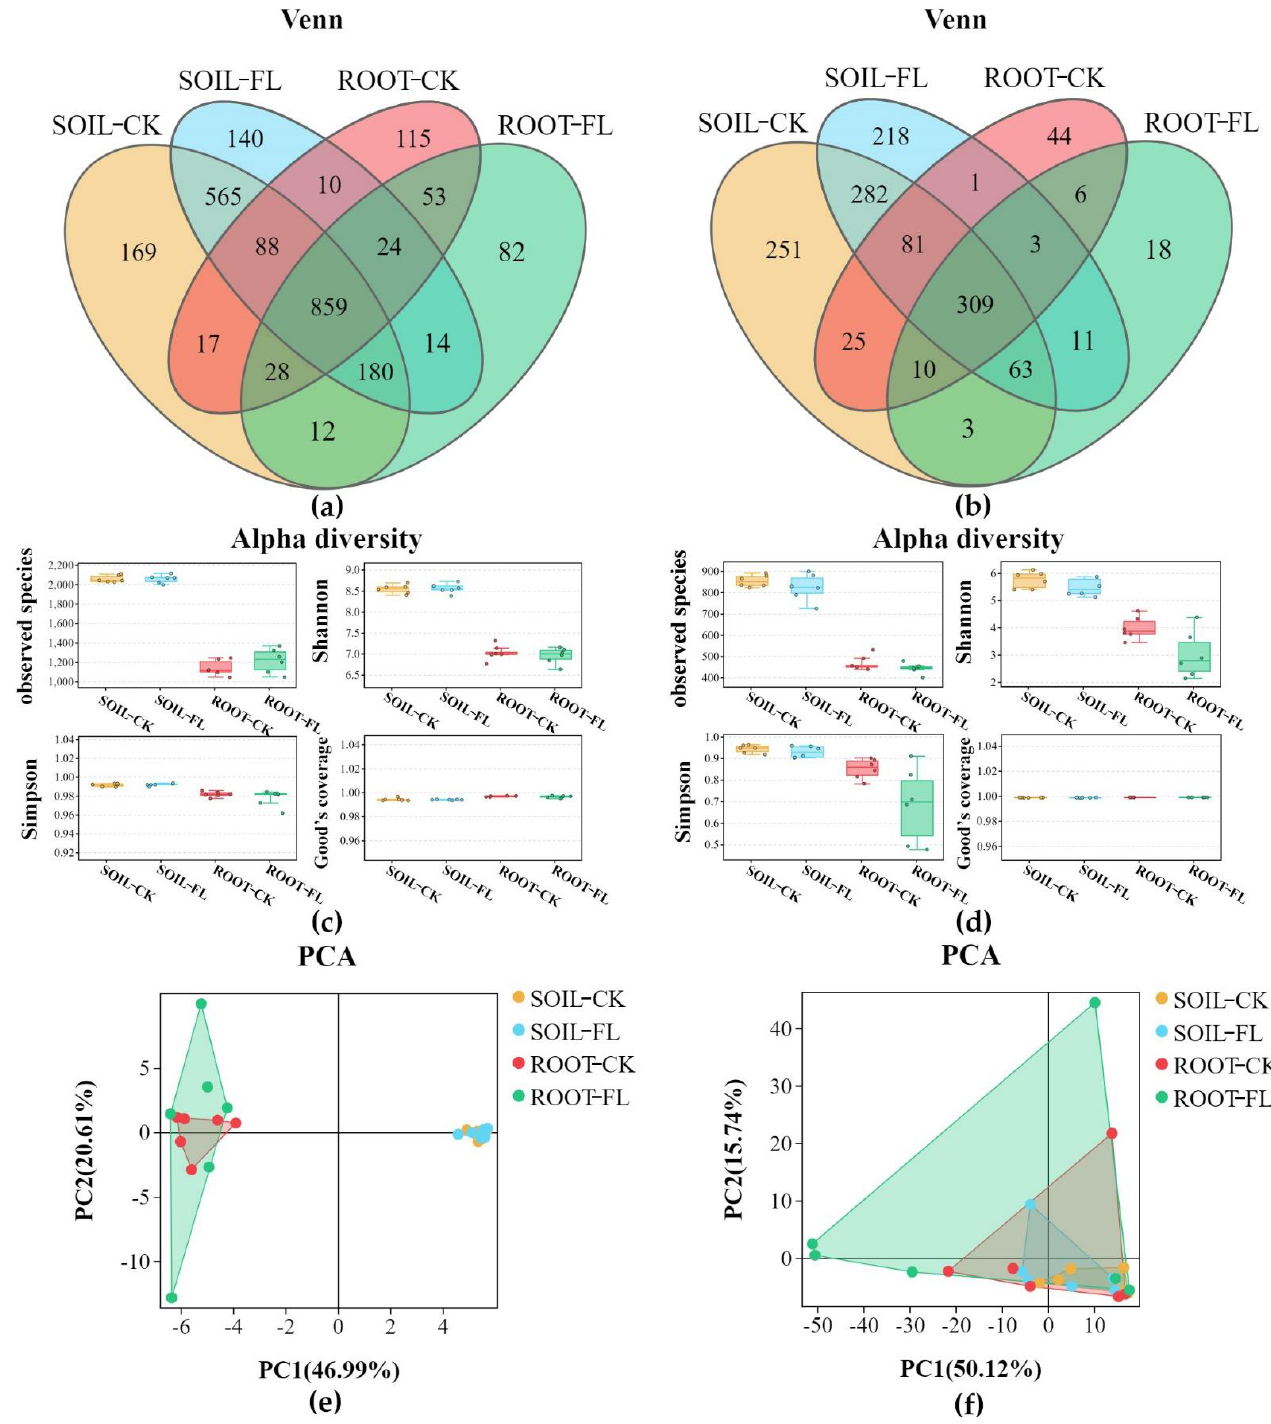
Figure 3. Venn analysis, alpha diversity analysis, and principal component analysis based on the recovered OTUs. ( a , b ) Venn analysis of bacteria and fungi, respectively; ( c , d ) alpha diversity analysis for bacteria and fungi using Tukey’s HSD; ( e , f ) principal component analysis of the OUT of the bacteria and fungi from soil and roots under FL and CK. The colored dots in the figures correspond to the different sample groups.